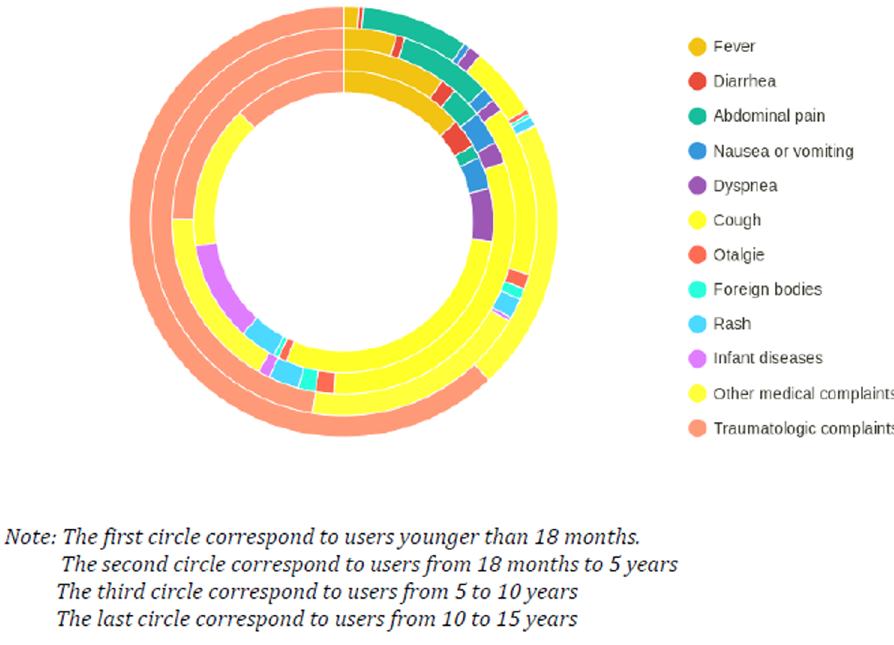
Fig 2. Type of chief complaint of user younger than 15 years, by